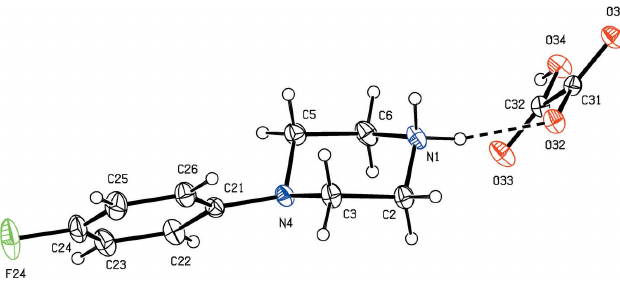
Figure 2 The independent components of compound (II) showing the atom- labelling scheme and the hydrogen bonds (drawn as dashed lines) within the asymmetric unit. Displacement ellipsoids are drawn at the 30% probability level.